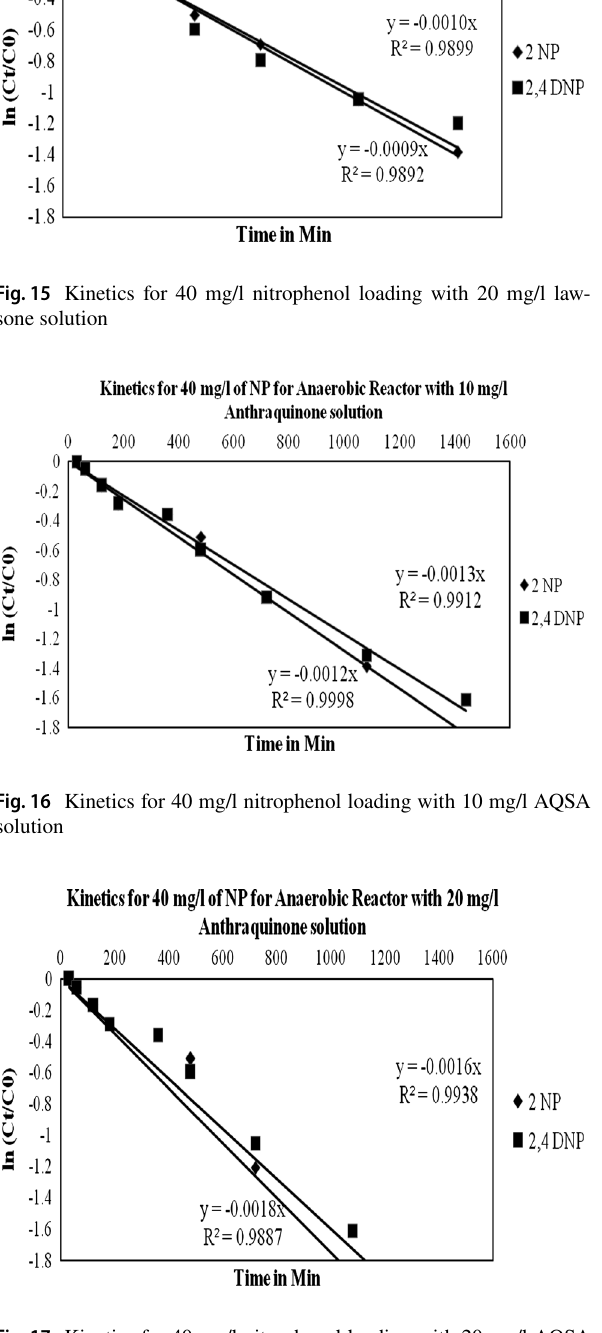
Fig. 17 Kinetics for 40 mg/l nitrophenol loading with 20 mg/l AQSA